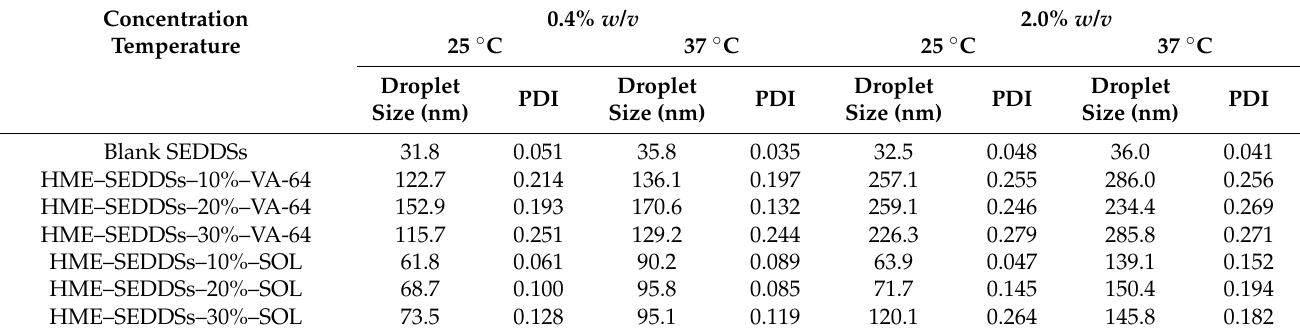
Table 2. Mean droplet size and polydispersity index of liquid SEDDSs and HME–SEDDSs after 0.4% and 2.0% w/V dilution in deionized